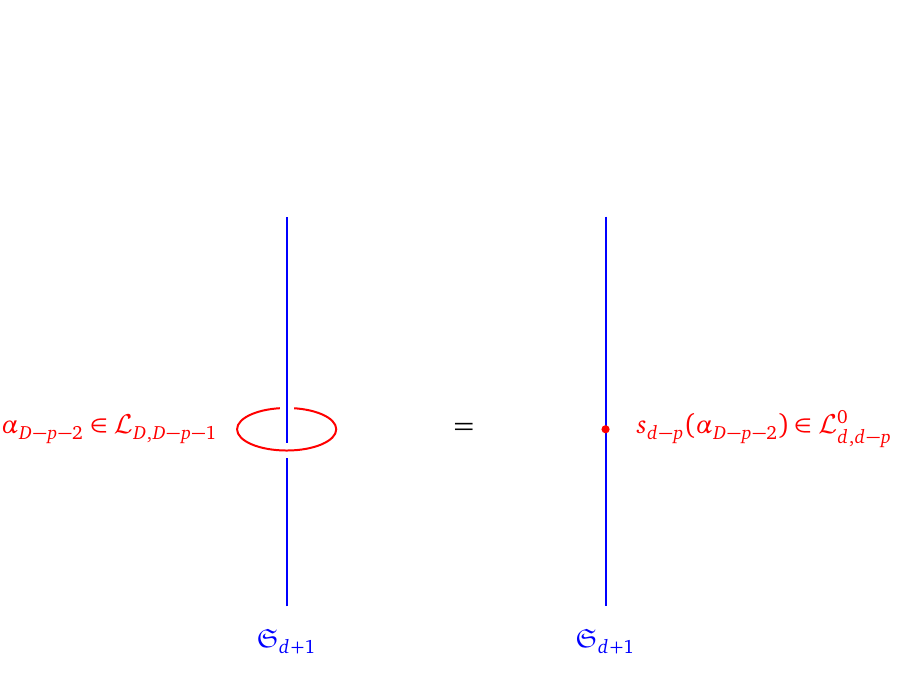
∈ L of the TQFT S along D − p − 2 D , D − p − 1 D + 1 , and squeezing it, gives rise d + 1 ( α ) ∈ L of the topological defect S . Since the sub- d − p D − p − 2 d , d − p d + 1 d , d − p